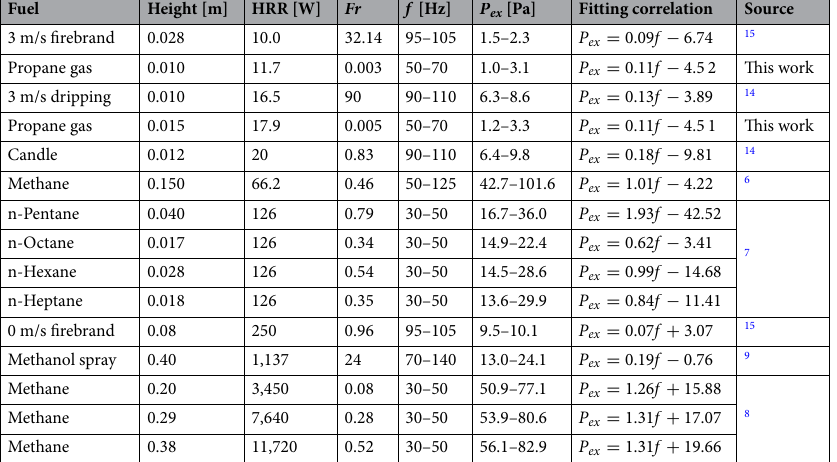
Table 2. Summary of acoustic extinction limit and the flame parameter, where the unit of P ex is Pa.